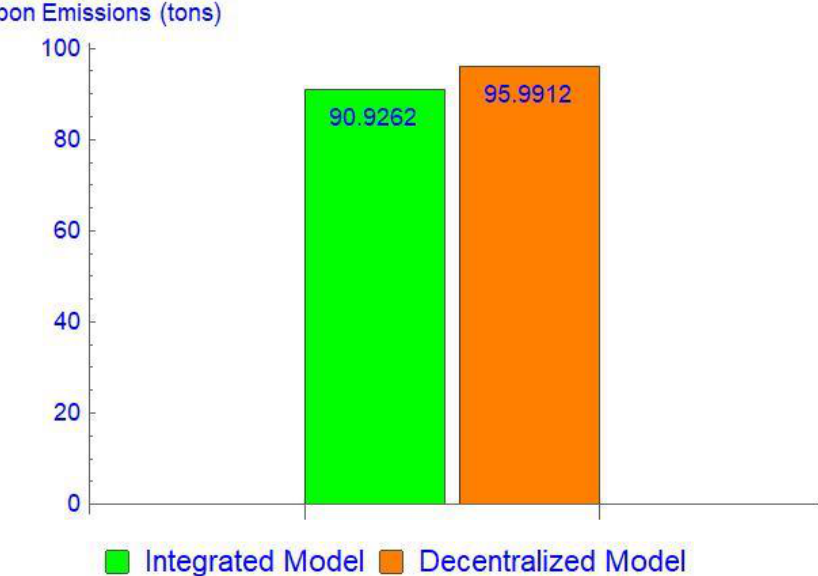
Figure 4. Comparison of amount of carbon emission under the integrated model and a decentralized model. Table 6. Sensitivity analysis for the total SC cost (The Integrated SC for Example 1).